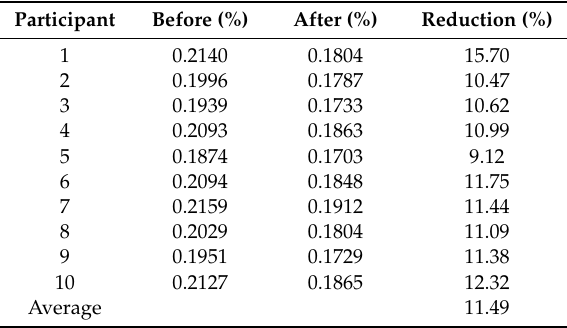
Table 5. MSI results for ten laps